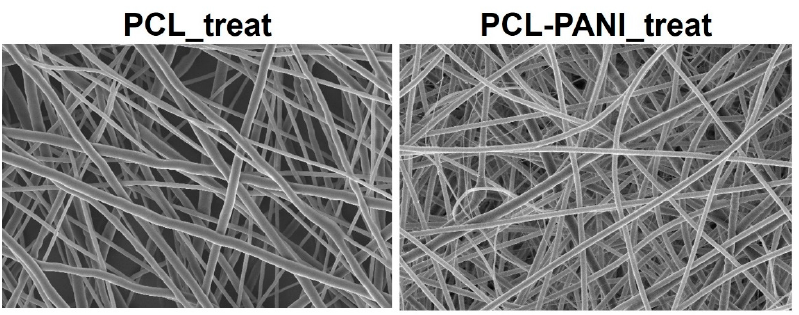
Figure 6. FESEM micrograph of PCL and PCL-PANI after Ar cold atmospheric plasma treatment (scale bar = 10 µm, magnification = 5 K×). No alterations in fiber morphology were detected after plasma treatment compared to untreated samples.